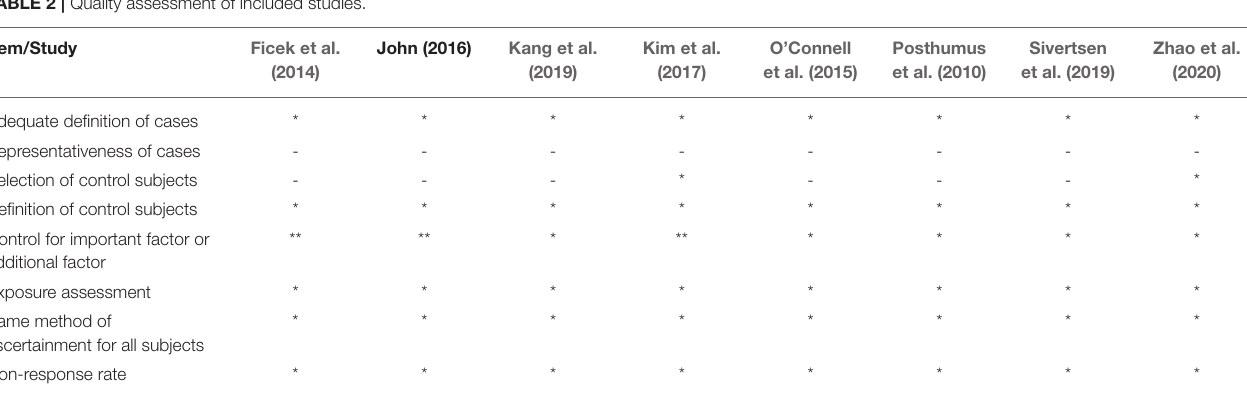
TABLE 2 | Quality assessment of included